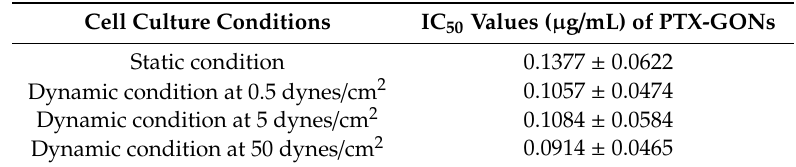
Table 2. IC 50 values ( µ g / mL) of PTX-GONs at di ff erent cell culture conditions (data are expressed as mean ± SD, n =